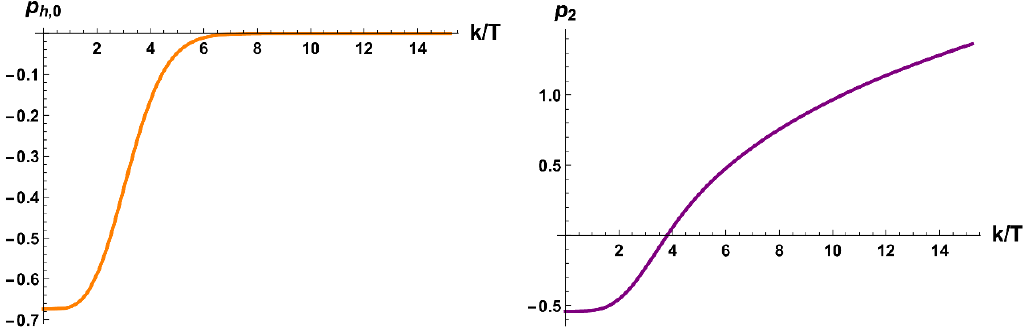
Figure 9 . Bulk scalar behavior in the background geometry dual to a phase of the model with explicit Z 2 symmetry breaking at (cid:12)xed (cid:14) 2